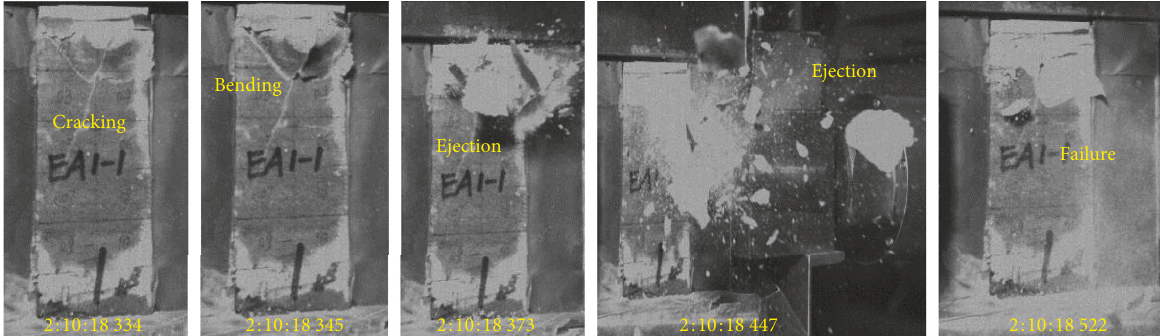
Figure 3: Failure process of the argillaceous sandstone in the strain burst test captured by the high-speed camera